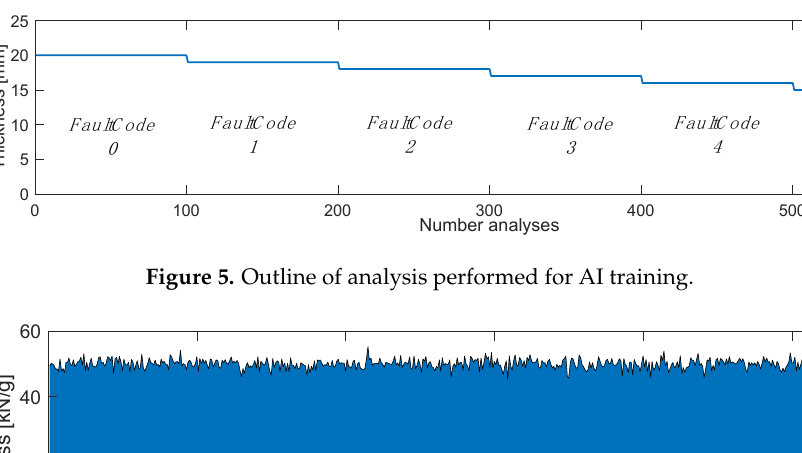
Figure 6. Stochastic variation in mass.